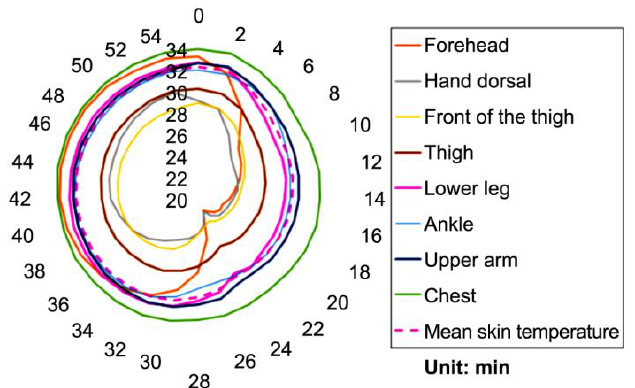
Figure 4. Temporal variations in the participants’ skin temperatures at various body parts at the 24 °C condition.